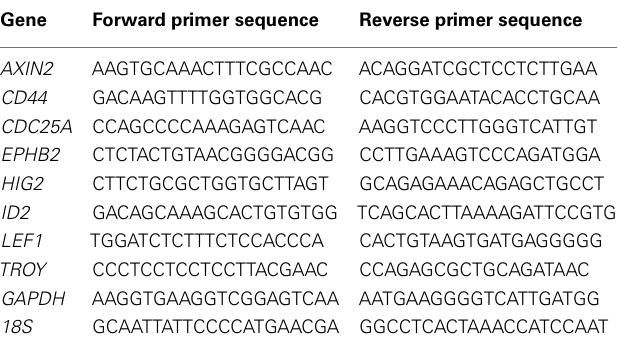
Table 1 | Prime sequences for